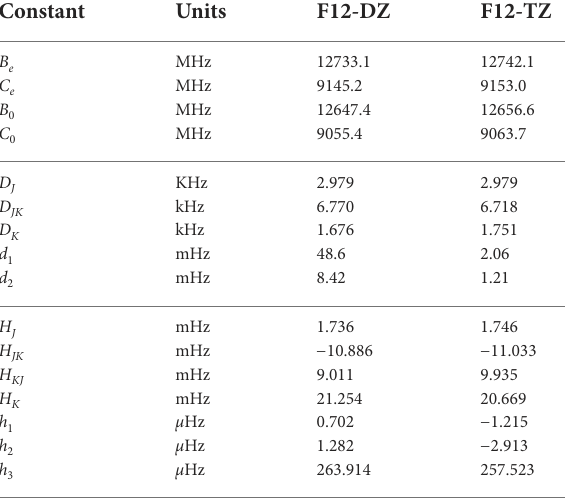
TABLE 4 Rotational constants of bipyramidal C 5 H 2